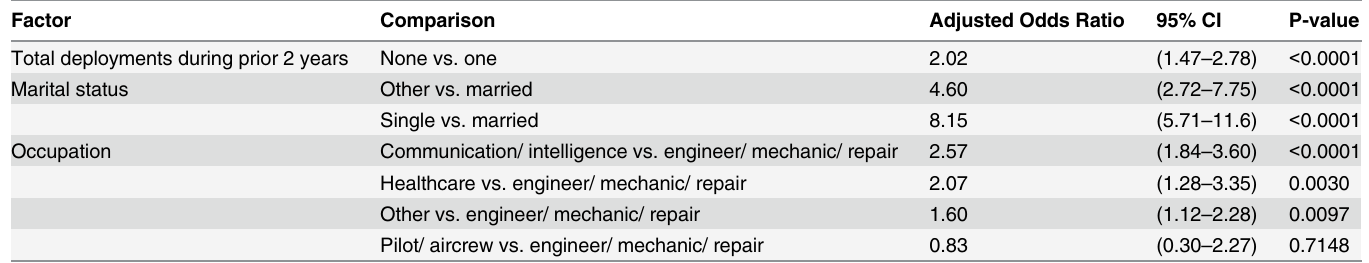
Table 4. Characteristics retained in multivariate conditional logistic regression